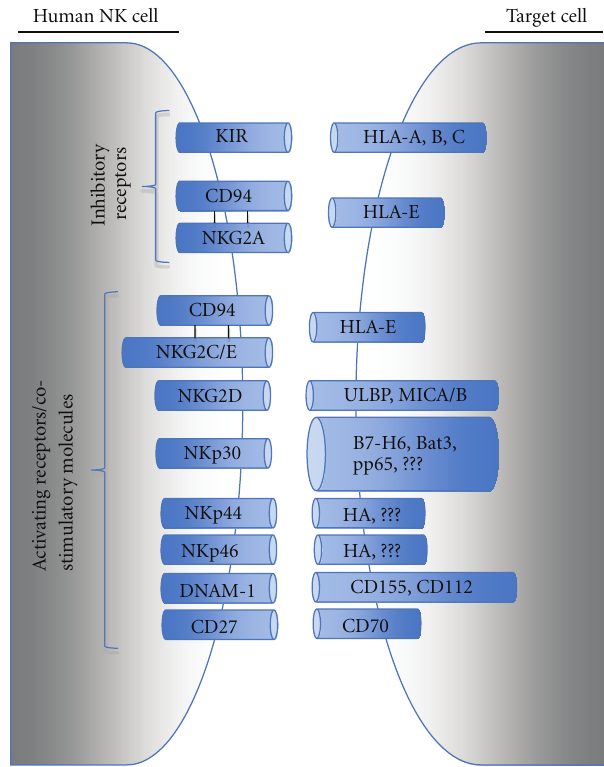
Figure 2: NK cell activation is mediated by a variety of cell surface inhibitory and activating receptors that recognize cell surface ligands on target cells. Viral infection, oncogenic transformation, and cellular stressors result in the downregulation in ligands for NK inhibitory receptors while concomitantly increasing the expression of NK activating ligands. Despite the presence of both activating and inhibitory signals on target cells, the overall balance of these signals dictates NK activation and target cell